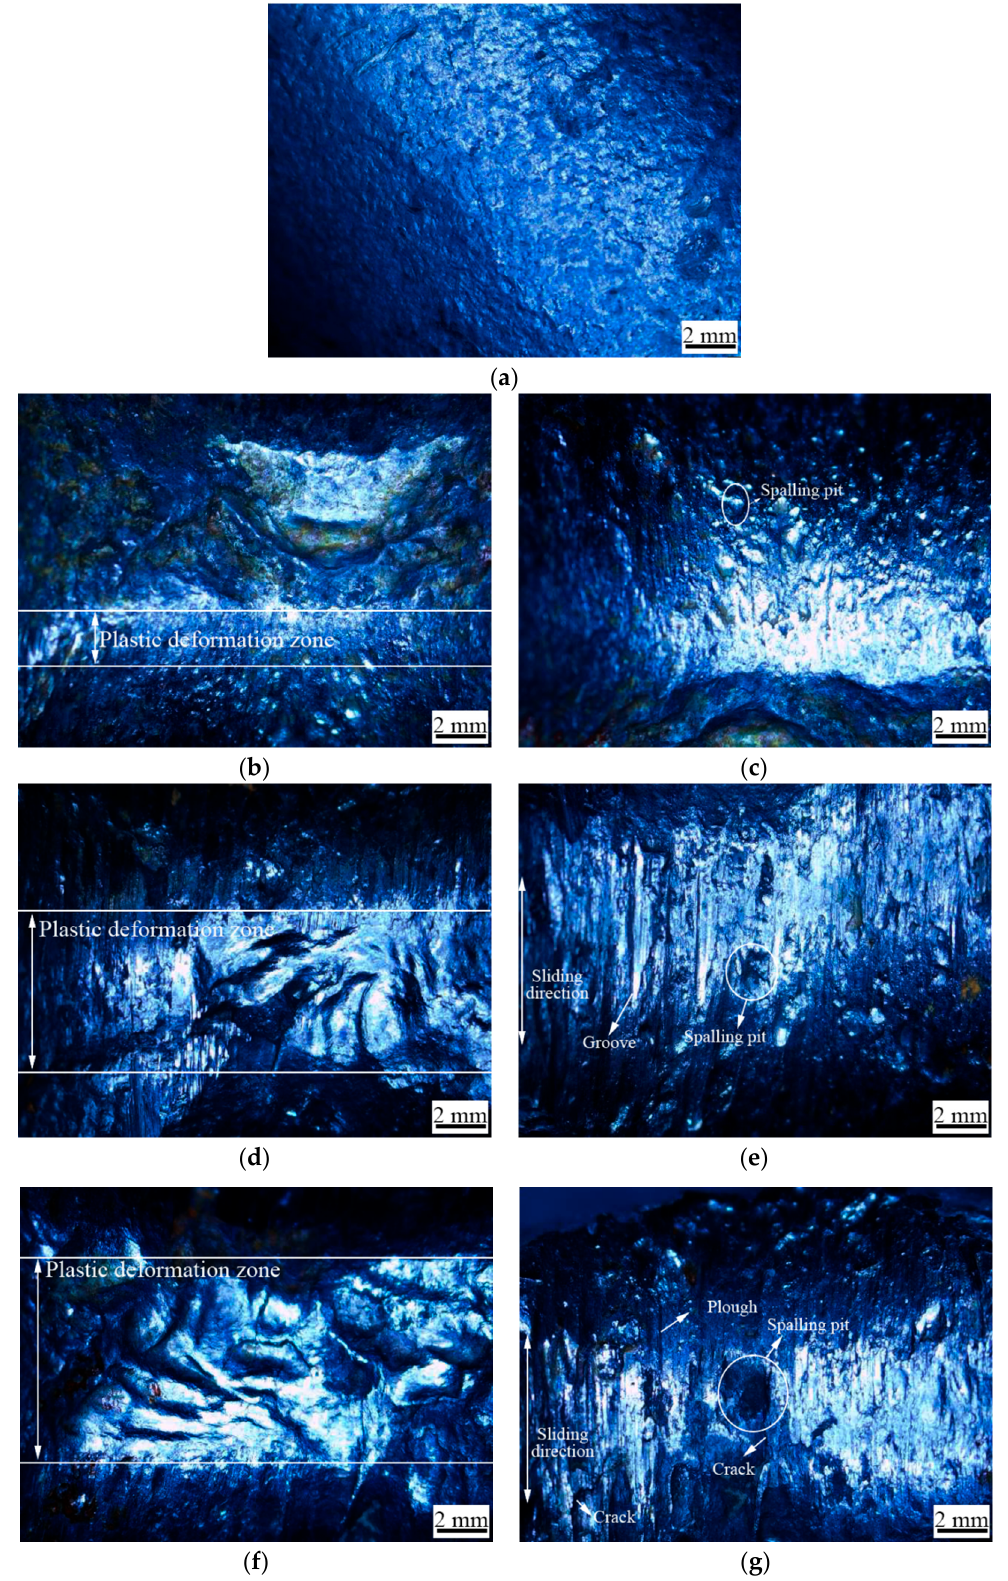
Figure 3. Surface morphology of the worn surface, ( a ) the original sample; ( b )wear load 4000 N; ( c ) wear edge on wear load 4000 N; ( d ) wear load 6000 N; ( e ) wear edge on wear load 6000 N; ( f ) wear load 8000 N; ( g ) wear edge on wear load 8000 N.